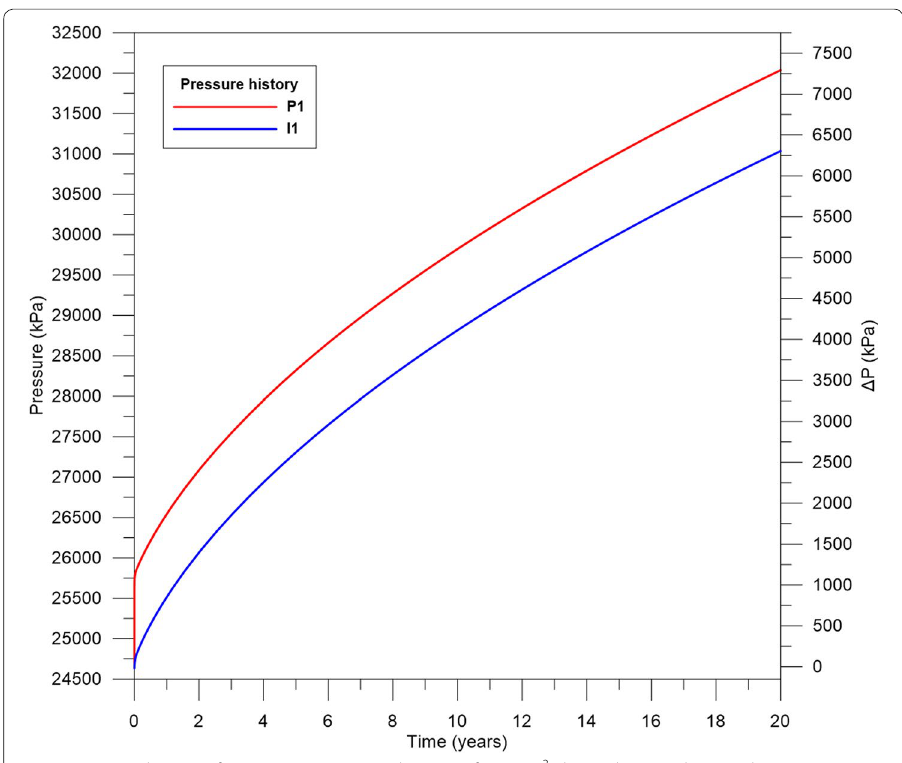
Fig. 8 Pressure history of constant injection with a rate of 3600 m 3 /day and no production during 20 years. Red curve represents P1 and blue curve represents